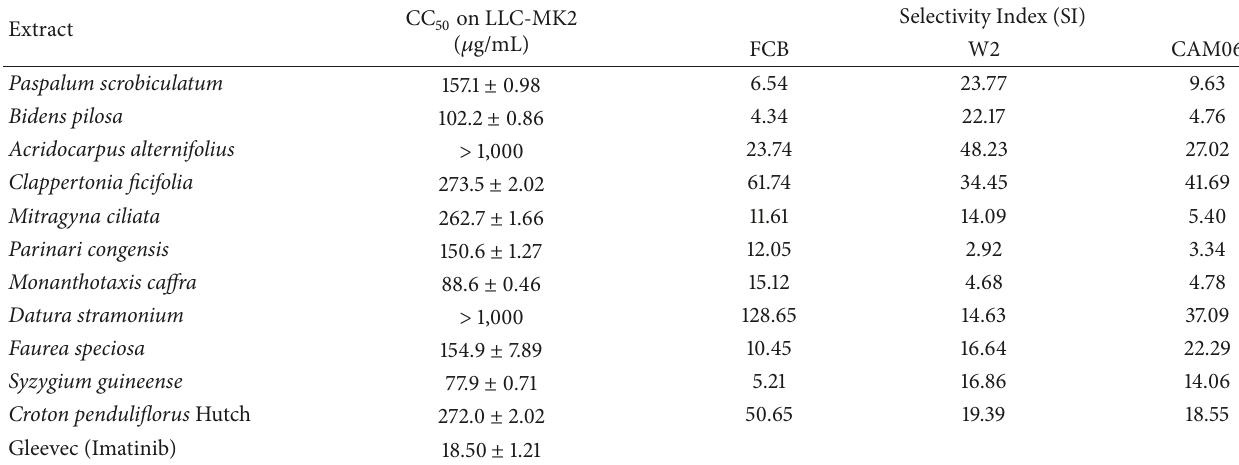
Table 4: Cytotoxicity of crude extracts in LLC-MK2 cells and selectivity index (SI) values in the three tested Plasmodium falciparum strains.